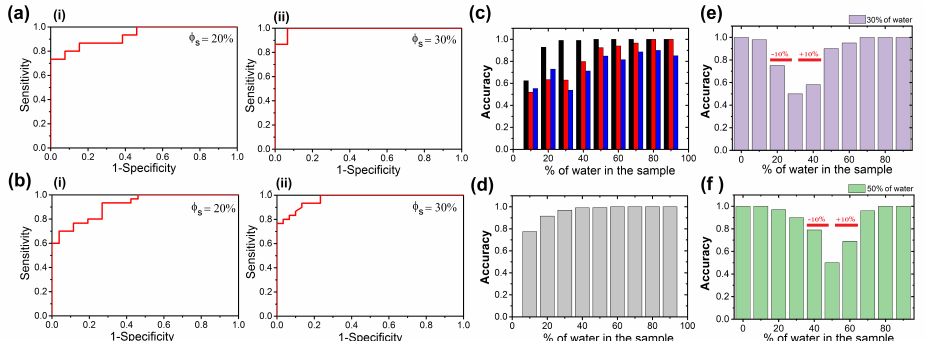
Figure 4. Receiver Operating Characteristic (ROC) curves. ( a ) (ROC) curves plotted from the entropy analysis of the crown in Methotrexate/NaCl patterns formed with varying ratios of tap water ( i ) 20, and ( ii ) 30%, respectively. ( b ) The ROC curves plotted from analysis of the normalized crown thickness γ / γ 0 of Methotrexate/NaCl patterns produced with varying ratios of tap water ( i ) 20, and ( ii ) 30%, respectively. ( c ) Accuracy for entropy estimated in different regions of Methotrexate/NaCl patterns: the crown (black), the center (red), and the complete deposit (blue). ( d ) Accuracy for the normalized crown thickness γ / γ 0 of Methotrexate/NaCl patterns. Accuracy for classifying groups of drug diluted with water at ( e ) 30% and ( f ) 50% by using entropy analysis of the crown in Methotrexate/NaCl